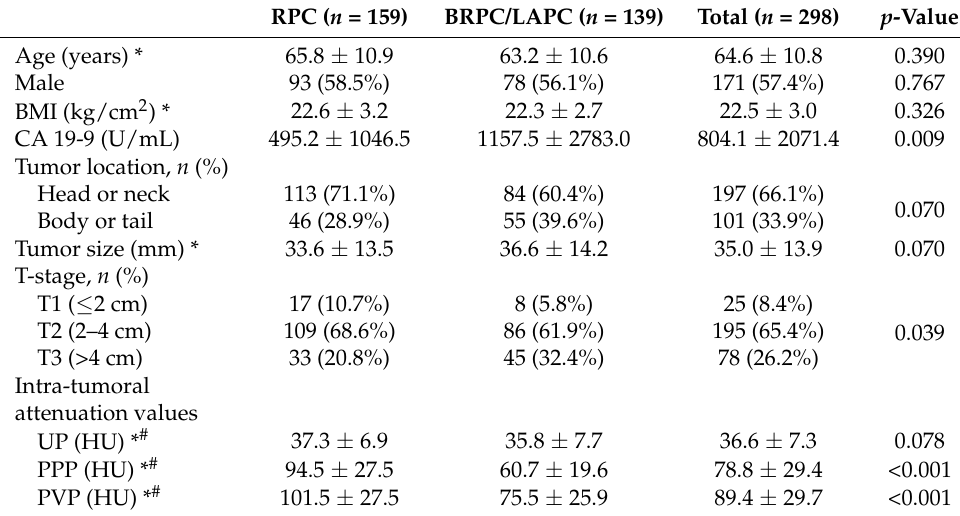
Table 1. Baseline characteristics of the study population ( n = 298).